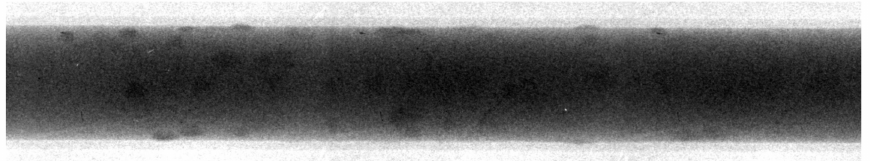
Figure 15. A full steel test sample with Zr cladding (diameter about 10 mm) after long-term irradiation in SINQ target 3; the black dots are interpreted as hydrogen accumulation at the outer side of steel towards the Zr cladding. Copyright by Taylor & Francis, 2001 [1].